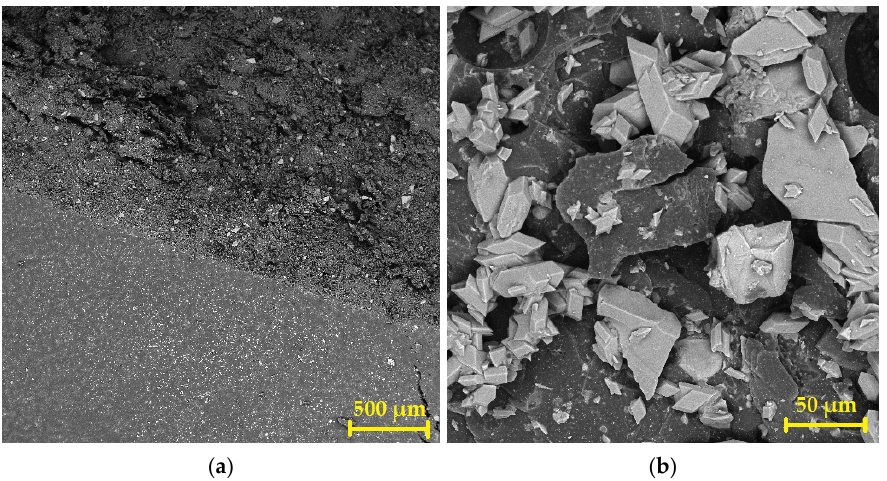
Figure 14. SEM photomicrographs of the coating NBR-CW containing shards from a windshield: ( a ) reference coating not exposed to the aggressive environment—50× magnification; ( b ) NBR-CW after ( a ) reference coating not exposed to the aggressive environment—50 × magnification; ( b ) NBR-CW exposure to CH 2 O 2 for 120 days—500× magnification. after exposure to CH 2 O 2 for 120 days—500 × magnification.